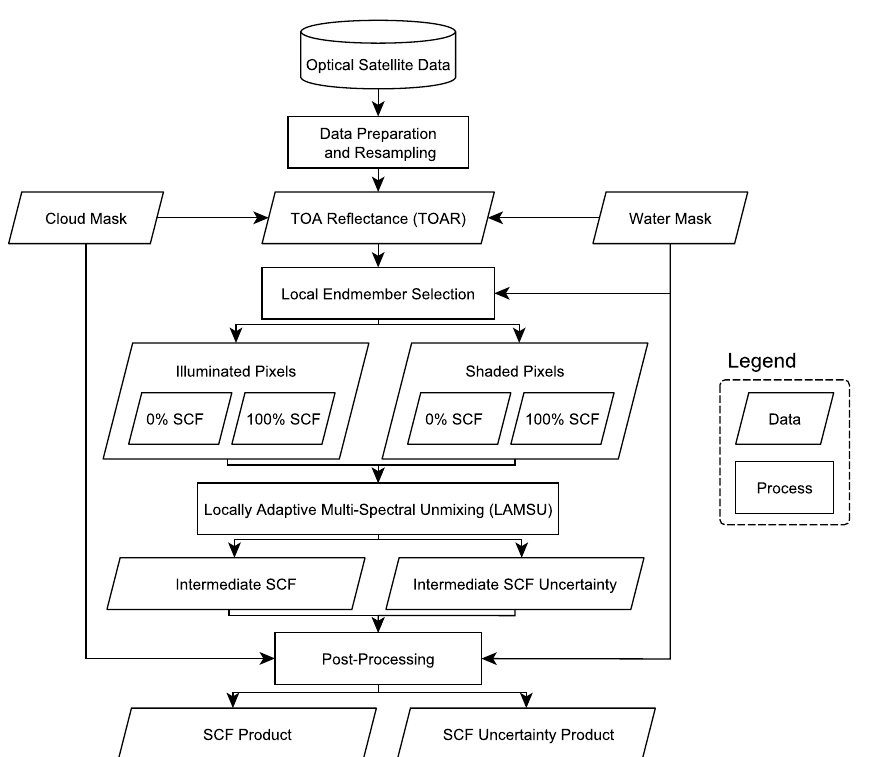
Figure 4. Proposed novel adaptive SCF estimation method with LAMSU at the core of the processing